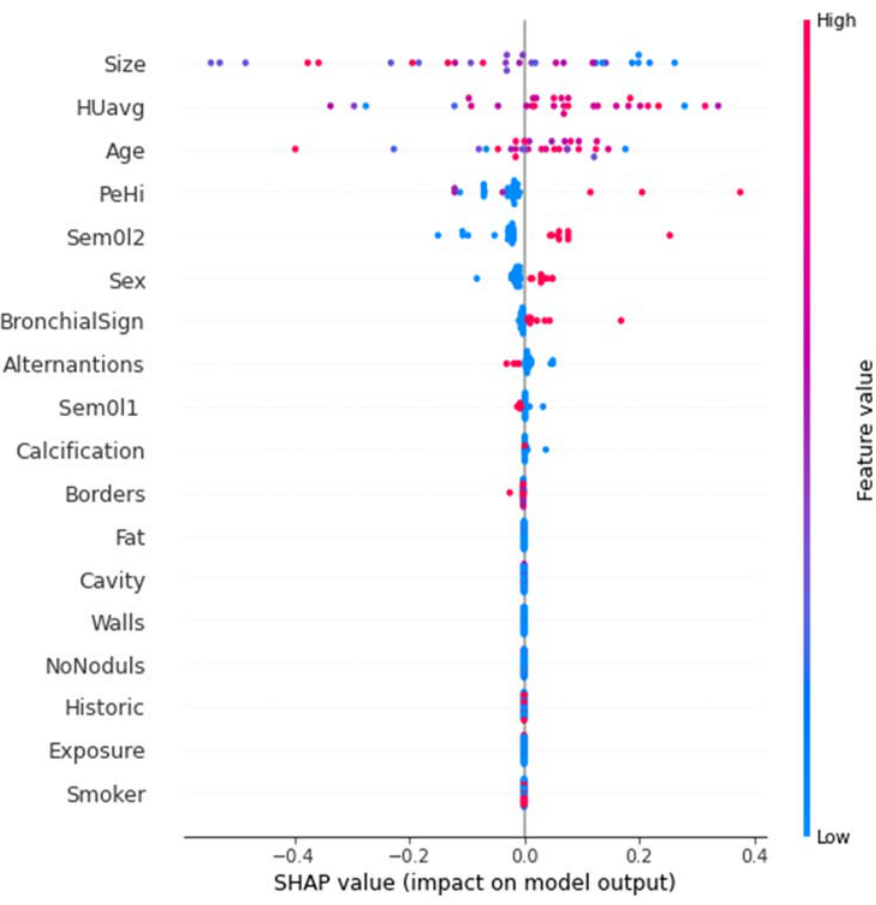
Figure 8. Global feature importance. SHAP explainable plot .